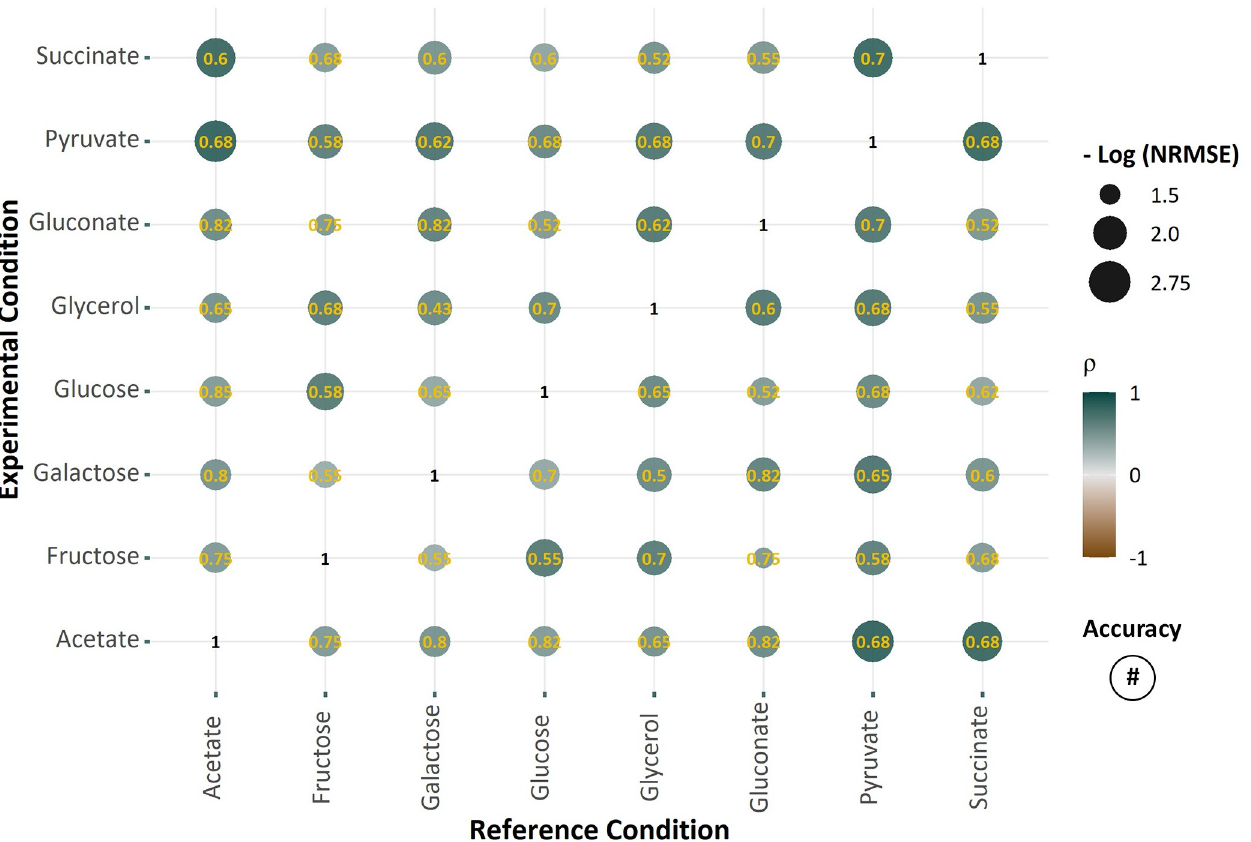
Fig 2. Prediction of metabolic flux changes in E . coli caused by changes in the carbon source using Δ FBA. The horizontal axis reports the reference carbon source (control) and the vertical axis shows the altered (perturbed) carbon source. Uncentered Pearson’s Correlation Coefficient ( ρ ) is shown by the color of the markers. NRMSE is represented by the size of the markers—the larger the markers, the smaller is the NRMSE. Finally, the directional (sign) accuracy of the flux perturbation predictions is shown by the numbers inside the markers.